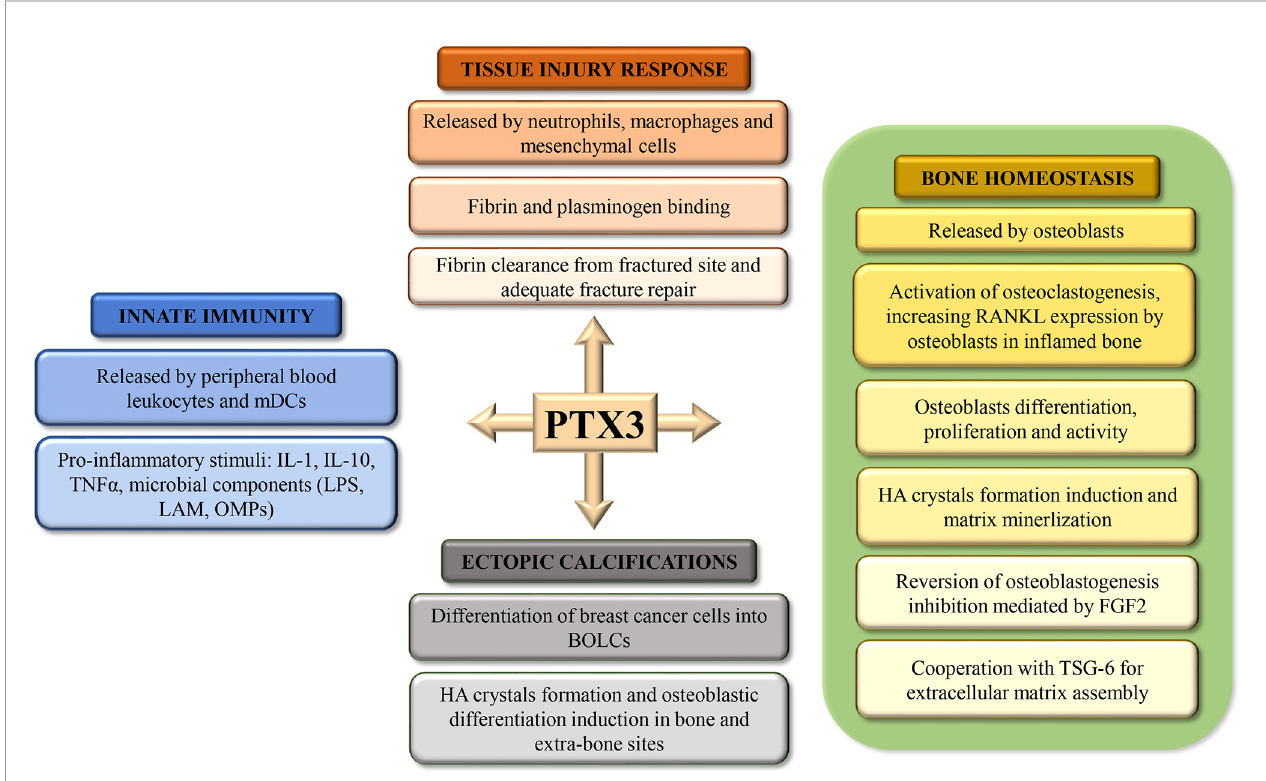
FIGURE 1 | Schematic representation of the roles of Pentraxin 3 (PTX3) in tissue injury response, bone homeostasis, ectopic calci fi cation, and innate